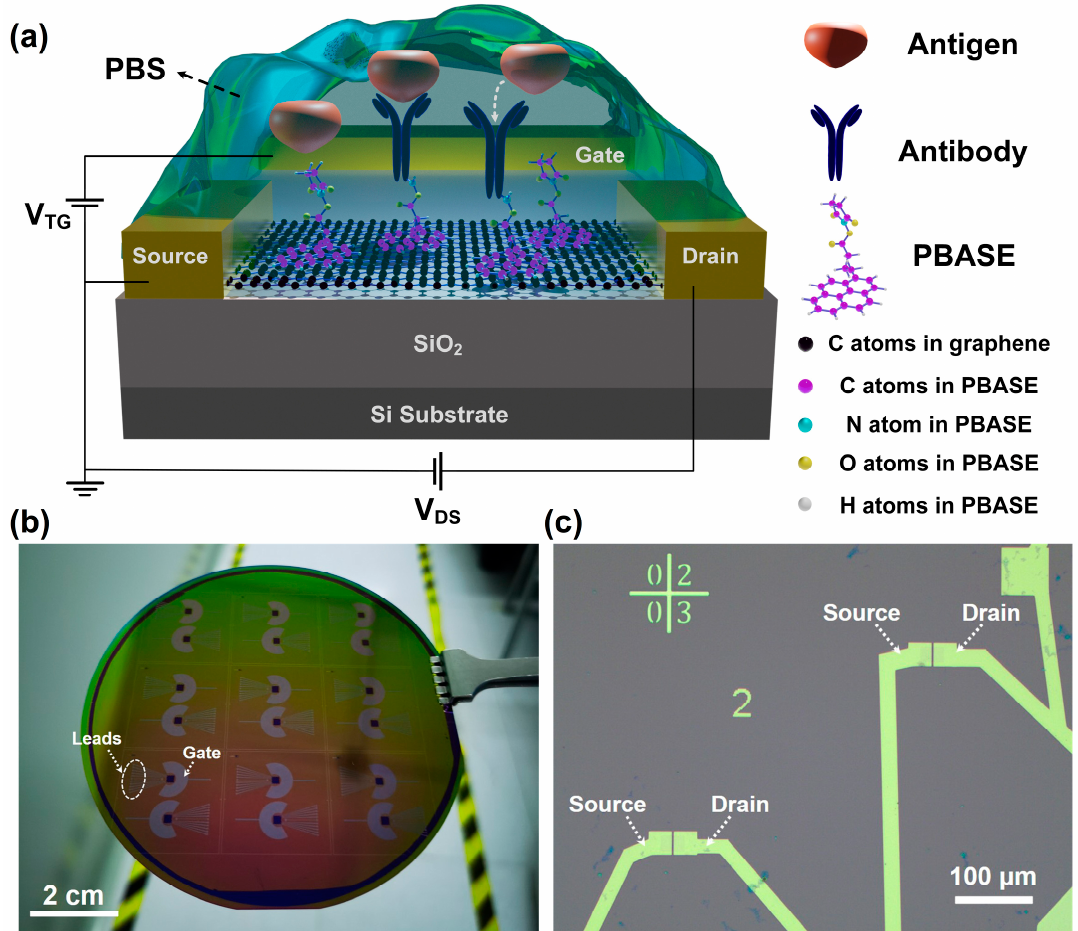
Figure 1. Three-dimensional (3D) schematic, the optical image, and the micrograph of the solution- gated graphene field-effect transistor (SGFET)-based biosensors. ( a ) The 3D schematic of the SGFET- based biosensor fabricated in this work and the bias configuration in electrical measurements. PBASE, 1-Pyrenebutyric acid N-hydroxysuccinimide ester. PBS, phosphate-buffered saline. V TG : gate voltage. V DS : drain-source voltage. The light gray dashed arrow indicates the biorecognition event of the antigen protein by the immobilized antibody. ( b ) The optical image of biosensor devices fabricated in bulk on a 100 mm wafer. The lavender half-ring indicated by the “Gate” mark is the in-plane gate electrode. Several thin lavender strips indicated by “Leads” are the external leads of the device. ( c ) The micrograph of two SGFET-based biosensors. Inside the slit between the source and drain electrodes is a graphene channel exposed to the electrolyte solution. The length of the exposed channel is 2 µ